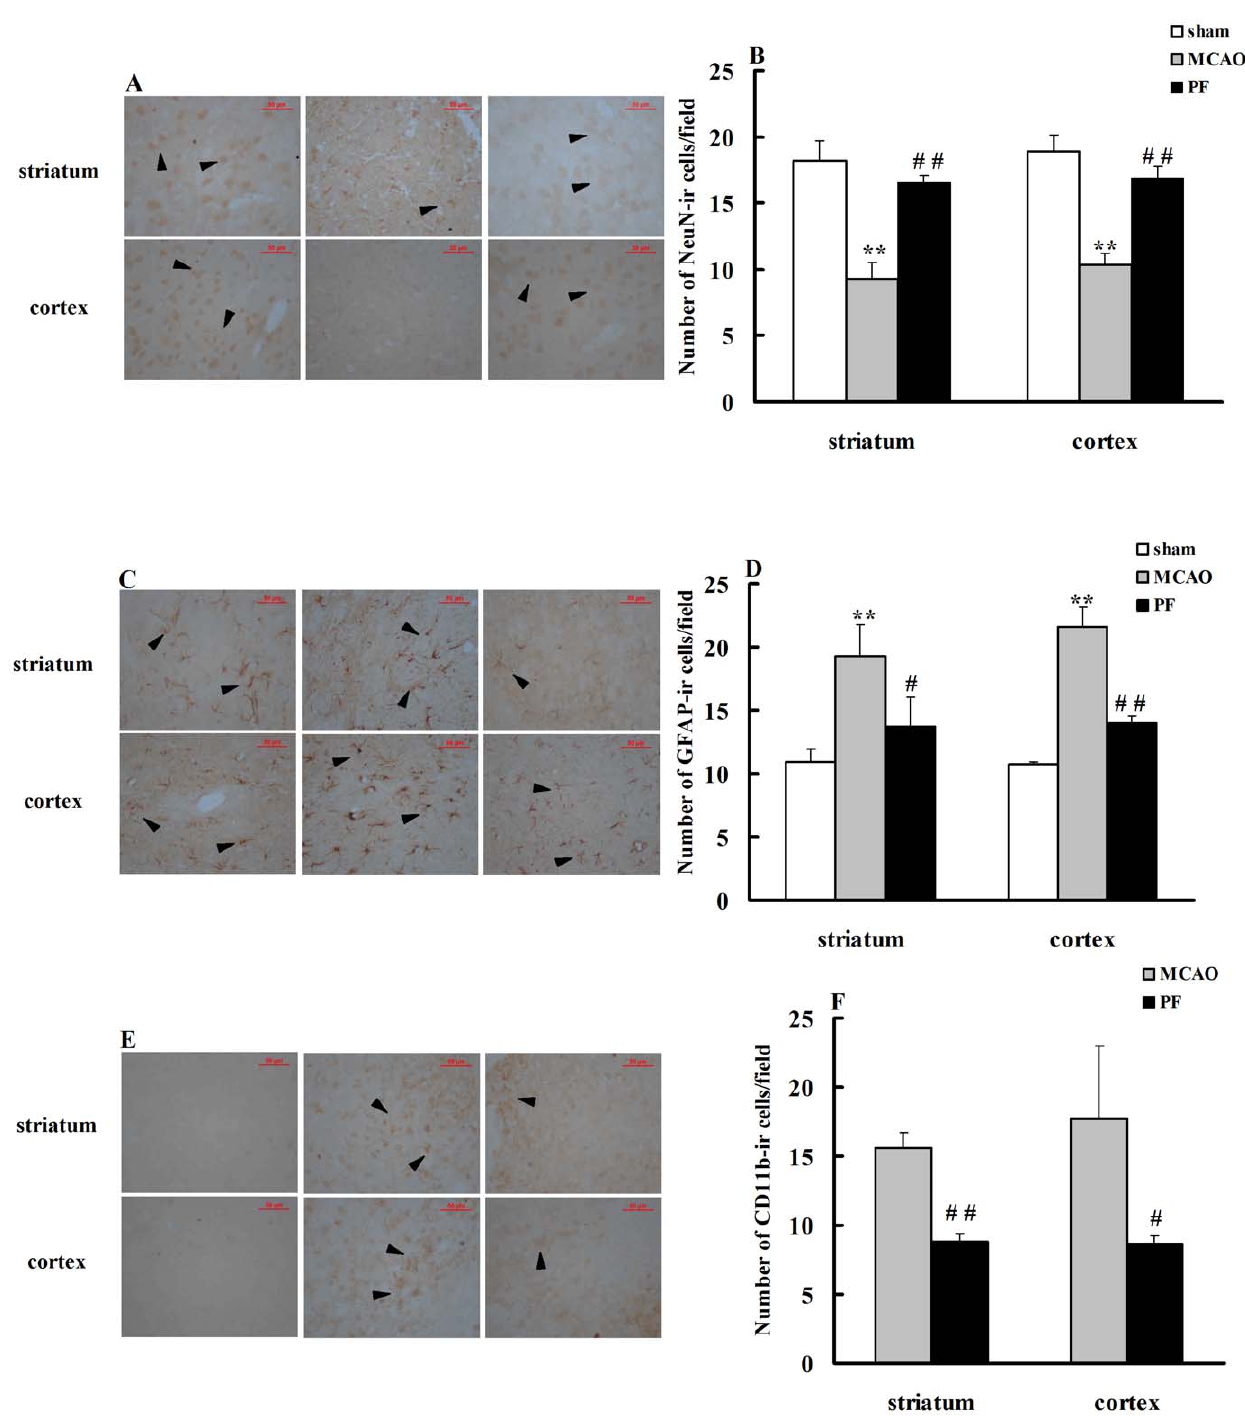
Figure 2. PF treatment inhibits activations of astrocytes and microglia, and prevents the loss of neuron. (A) Microphotographs of NeuN-ir cells in the cortex and striatum of rats with 6 40 objective. (B) Stereological counts of NeuN-ir cells in the rat brain. Sham, rats received surgery without vessel occlusion. (C) Microphotographs of GFAP-ir cells in the cortex and striatum of rats with 6 40 objective. (D) Stereological counts of GFAP-ir cells in the rat brain. (E) Microphotographs of CD11b-ir cells in the cortex and striatum of rats with 6 40 objective. (F) Stereological counts of CD11b-ir cells in the rat brain. Sham, rats received surgery without vessel occlusion; MCAO, rats treated with saline for 14 days after transient MCAO; PF, PF (5 mg. kg 2 1 ) was administered for 14 days after transient MCAO. n=4–6. All data were expressed as mean 6 SD. Black arrows indicated the positive staining. * P , 0.05,** P , 0.01 vs sham; # P , 0.05, ## P , 0.01 vs MCAO. Scale bar, 50 m m.